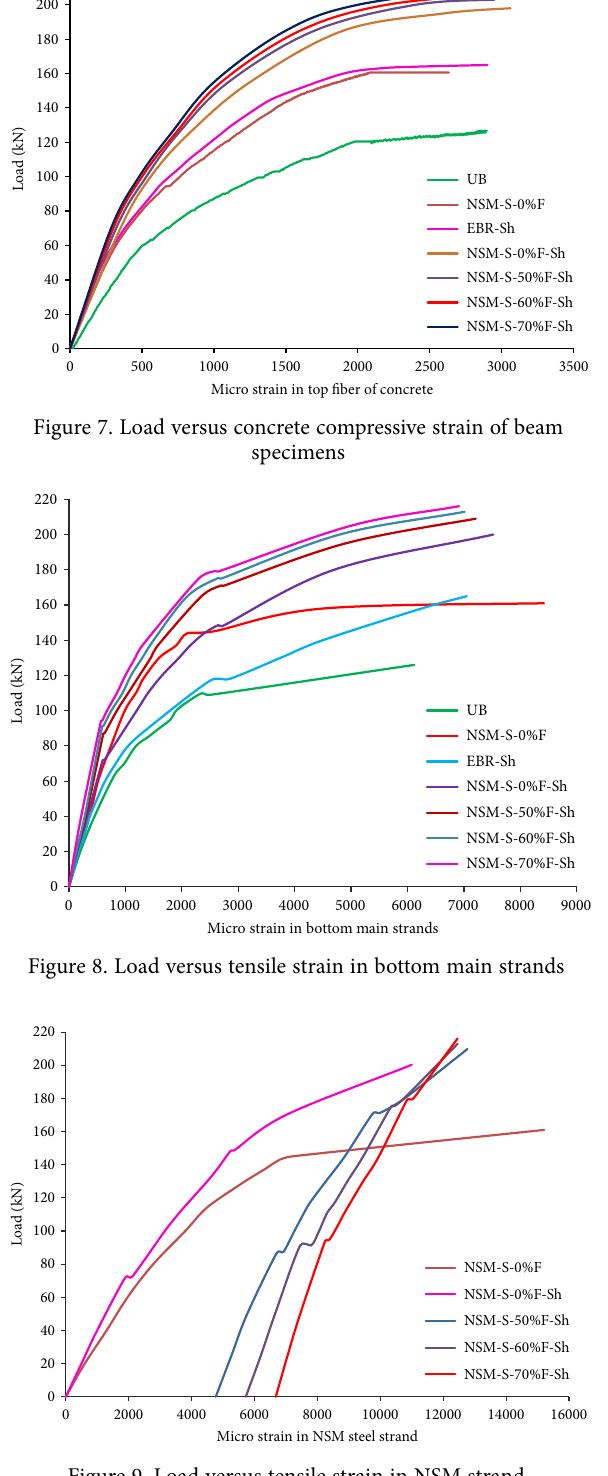
Figure 9. Load versus tensile strain in NSM